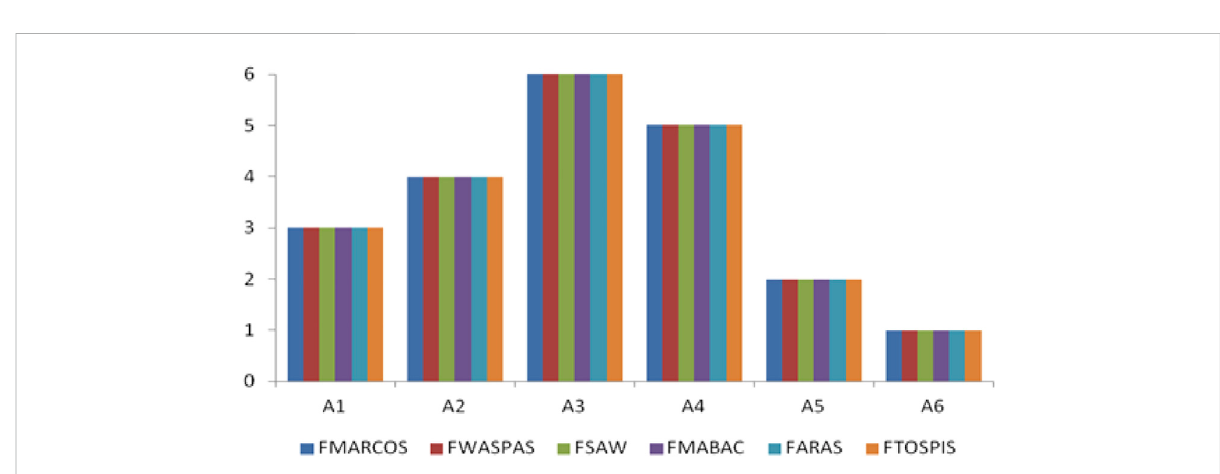
FIGURE 3 Ranking of the alternatives using different fuzzy methods. Source: according to authors